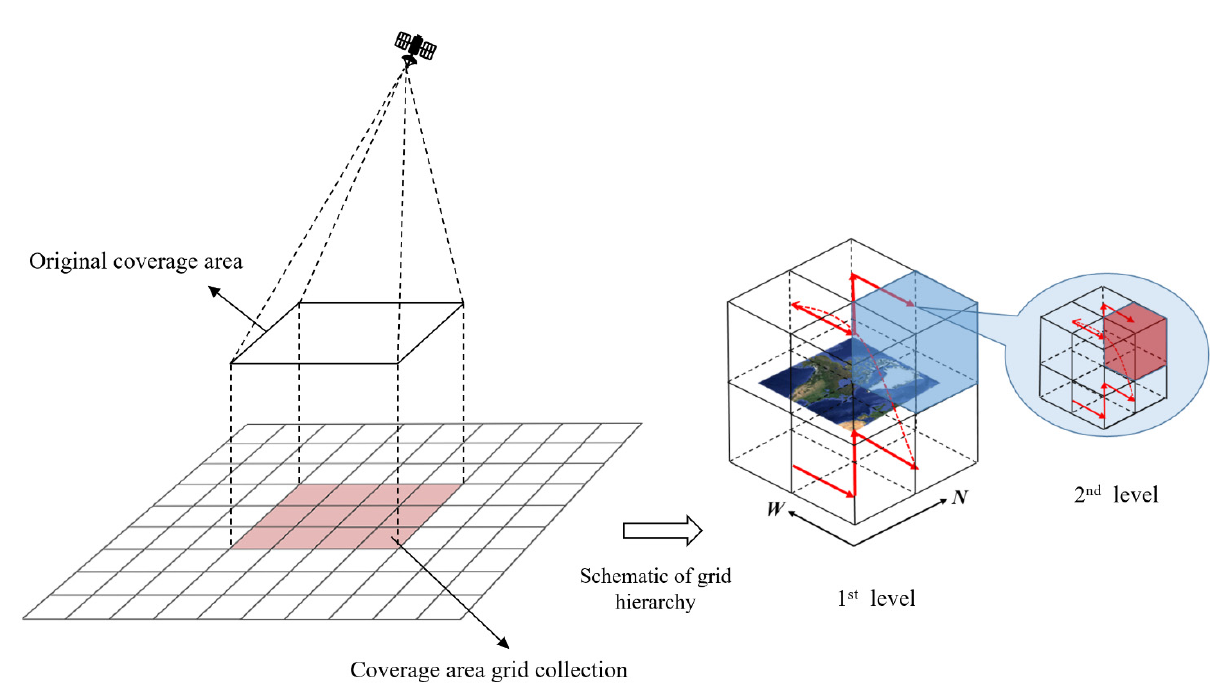
Figure 2. Grid-based modeling of satellite coverage areas.